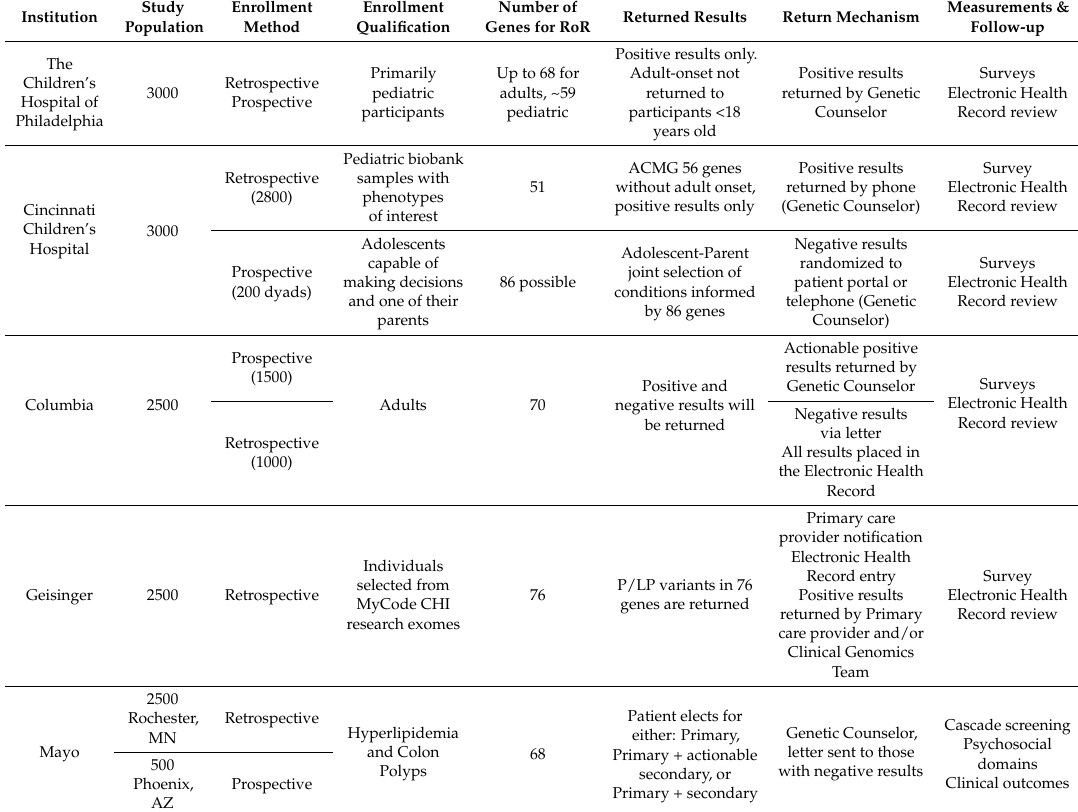
Table 1. Summary of each electronic MEdical Records and GEnomics (eMERGE) site’s genomic medicine